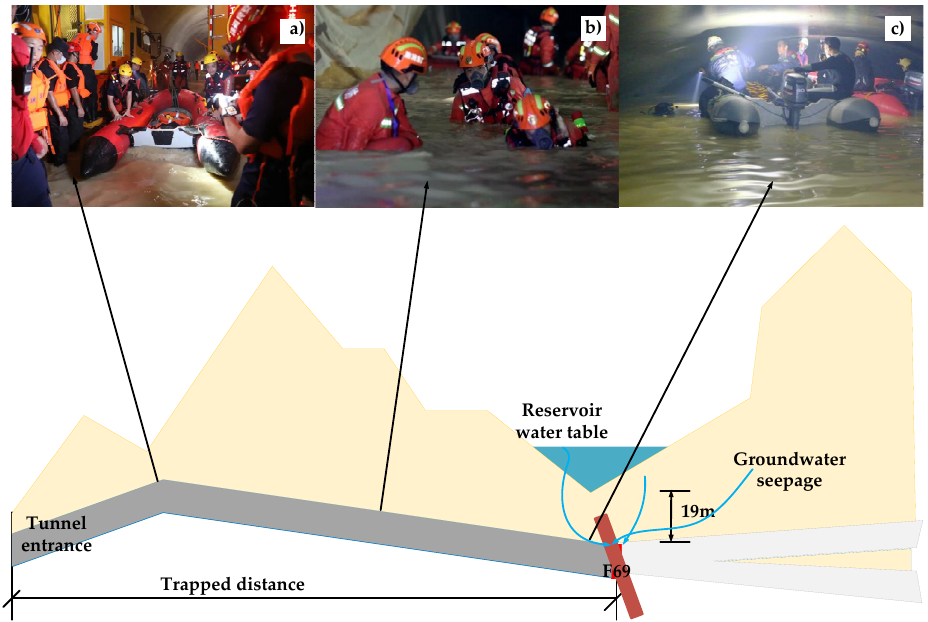
Figure 2. Zone water level in the tunnel after water inrush accident: ( a ) The transport port is at the